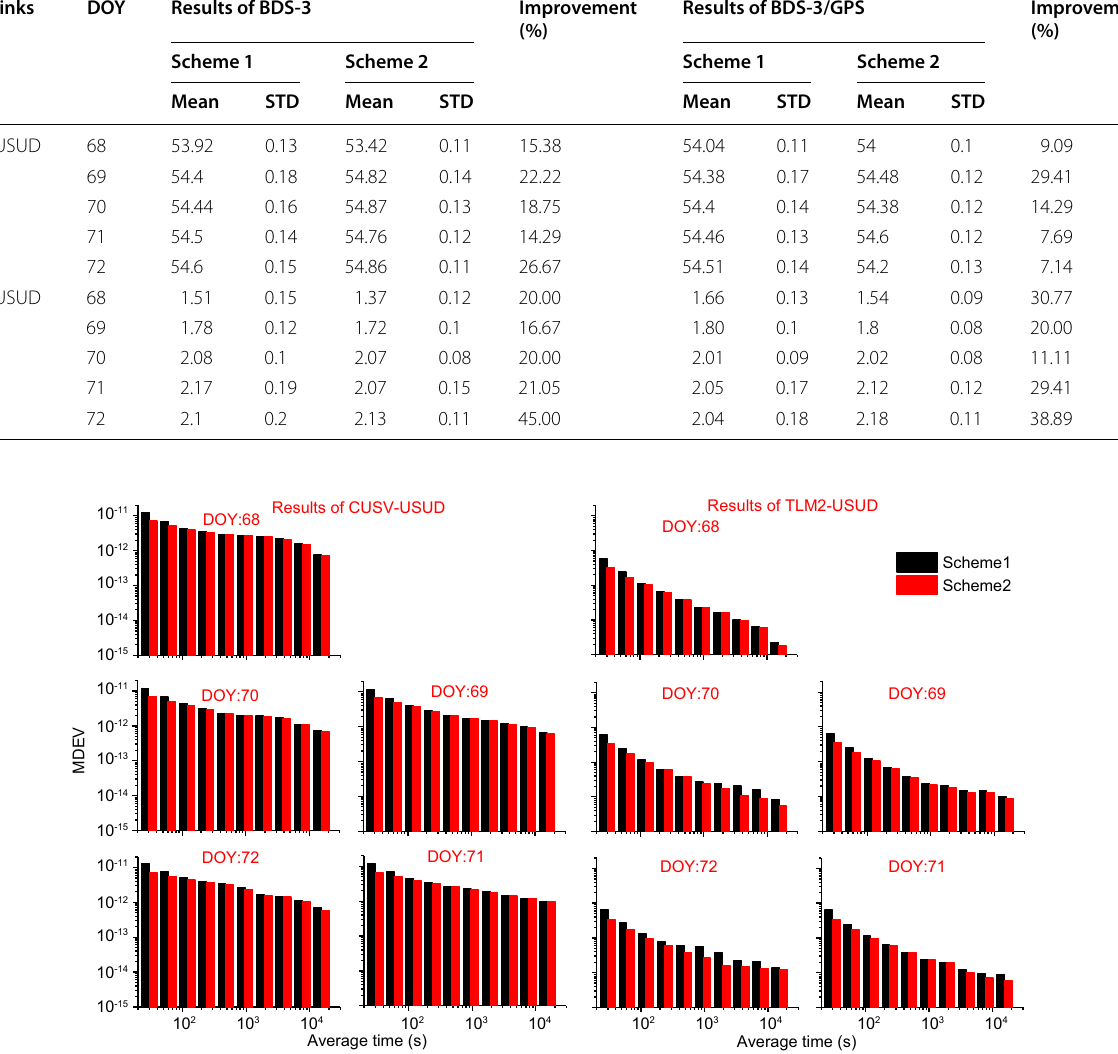
Fig. 14 MDEV of CUSV-USUD and TLM2-USUD from BDS-3 PPP Scheme 1 and Scheme